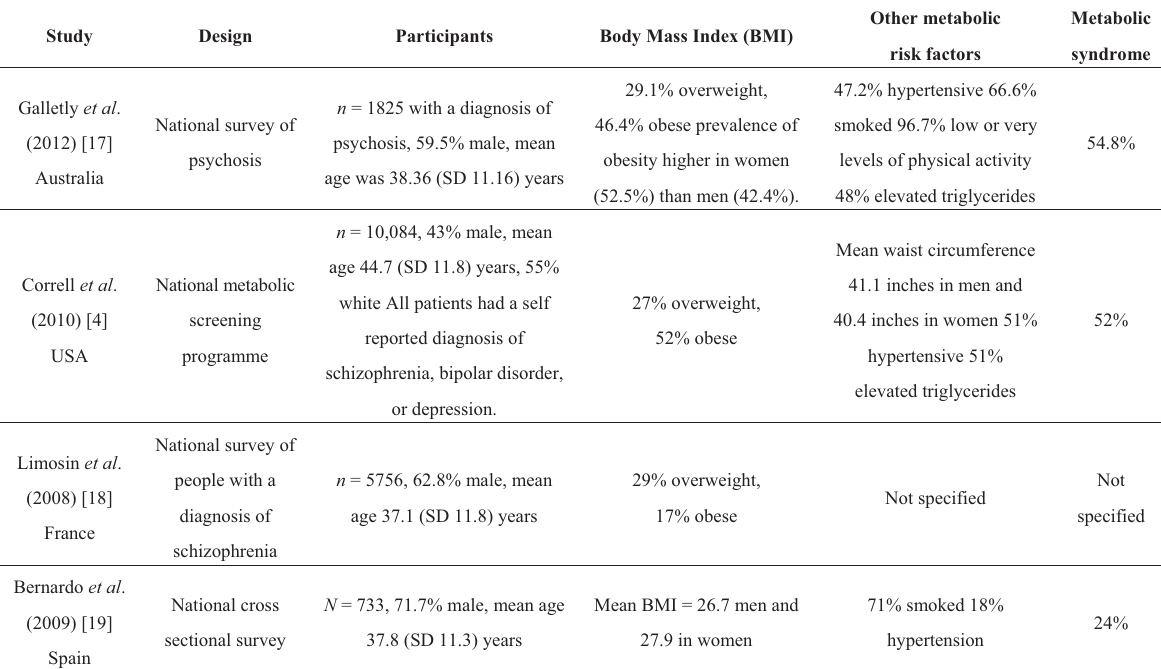
Table 2. National surveys of obesity in serious mental ill health